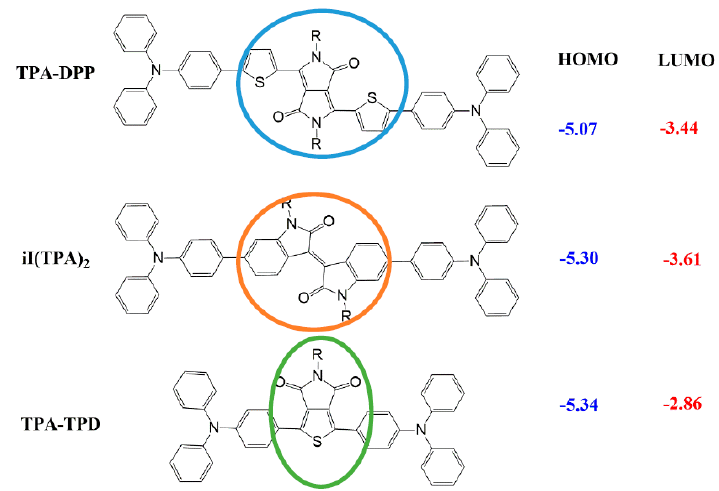
Figure 6. HOMO-LUMO energy level comparison of two low molecular weight molecules with D-A-D structures using iI [33], DPP [34], with respect to TPD as A fragments.